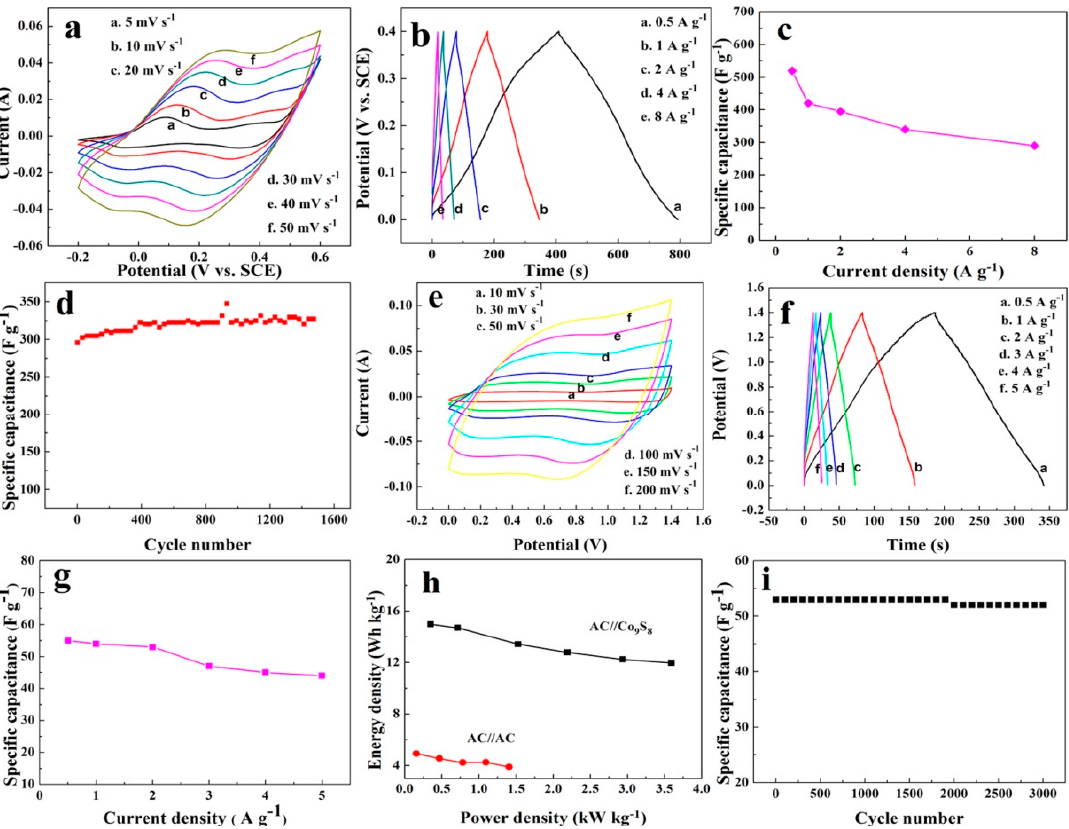
Figure 2. ( a ) CV curves and ( b ) charge/discharge curves of Co 9 S 8 . ( c ) Specific capacitance and ( d ) cycling stability of Co 9 S 8 . ( e ) CV curves and ( f ) charge/discharge curves of the AC//Co 9 S 8 supercapacitor. ( g ) Specific capacitance, ( h ) Ragone plots and ( i ) cycle stability.